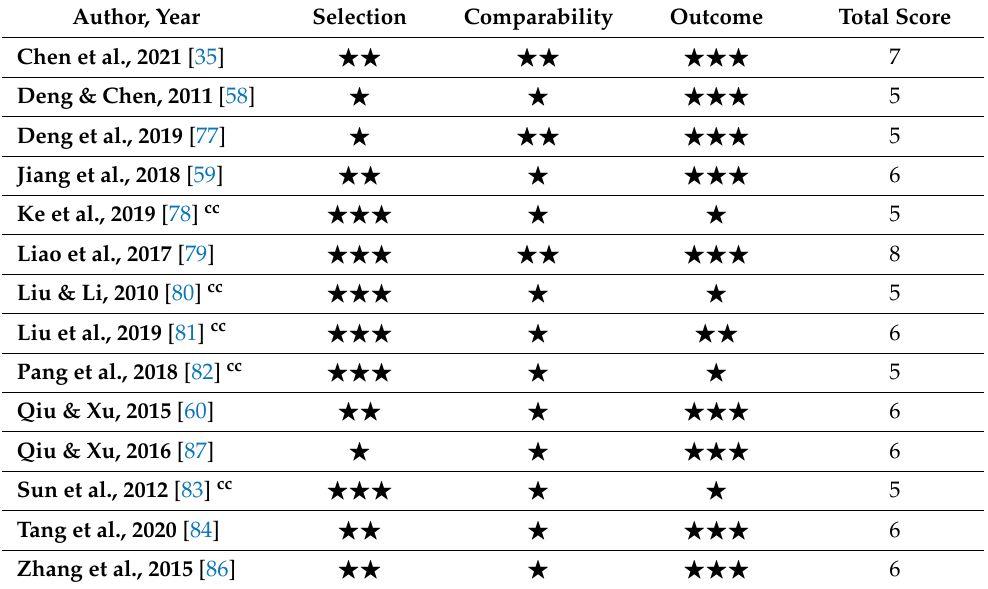
Table 3. Quality assessment of the included studies by the Newcastle–Ottawa Scale